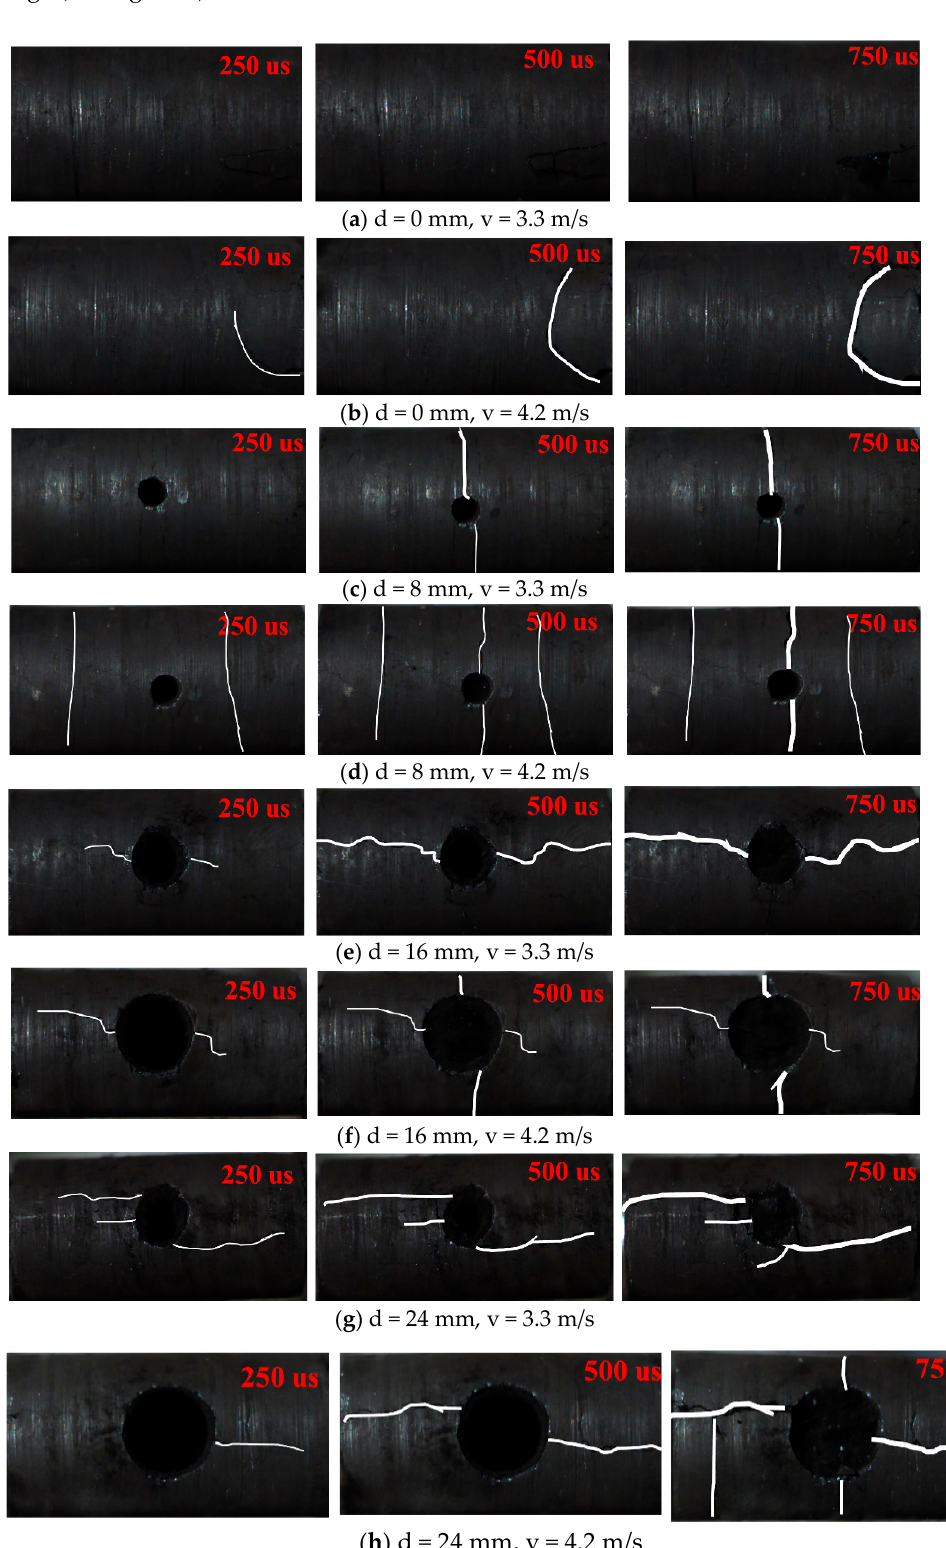
Figure 4. Process of dynamic rupture around the hole (The length and width of the white line represent the crack development and the crack width, respectively).